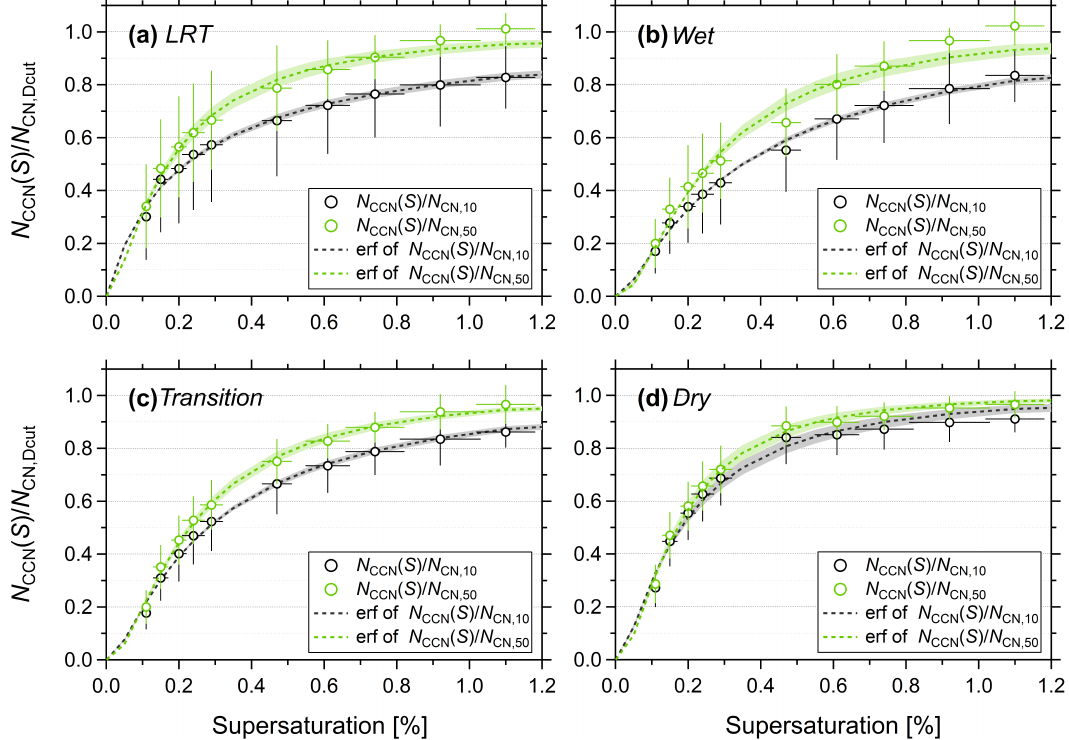
Figure 14. CCN efficiency spectra averaged over the entire measurement period for reference concentrations, N CN,10 and N CN,50 , and subdivided into seasonal periods of interest as specified in Sect. 3.3. The fit functions are error function fits (the dashed line with shading represents the uncertainty of the fit). The error bars at the markers represent the measurement error in S and 1 standard deviation (not the standard error, as in Fig. 10) in N CCN ( S)/N CN ,D . cut